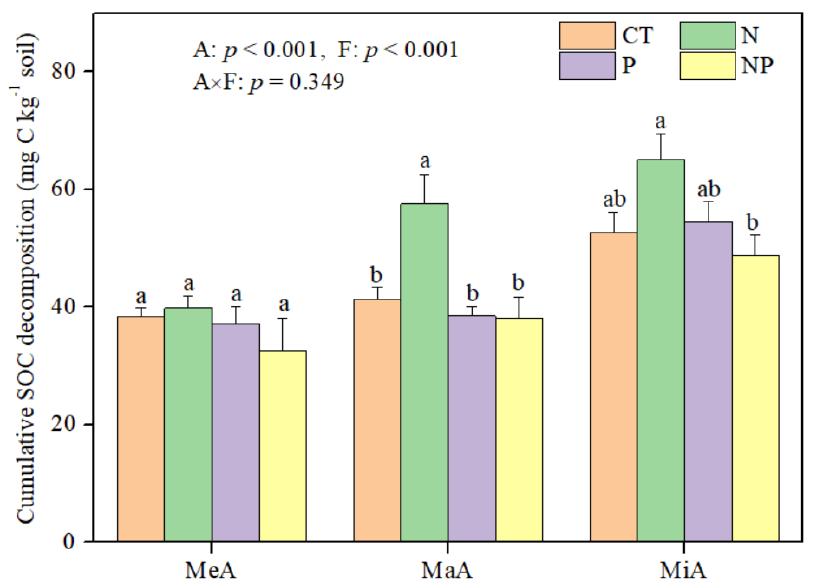
Figure 1. Effects of N and P fertilization on the cumulative soil organic C (SOC) decomposition in different size aggregates during 30-day incubation at 18 °C in a subtropical forest. F and A represent fertilization and soil aggregate size, respectively. Different letters on the bars denote significant differences among fertilization treatments. MeA, MaA, and MiA represent mega-aggregates (>2.0 mm), macroaggregates (0.25 – 2.0 mm), and microaggregates (<0.25 mm). Data were represented as the mean with standard error.